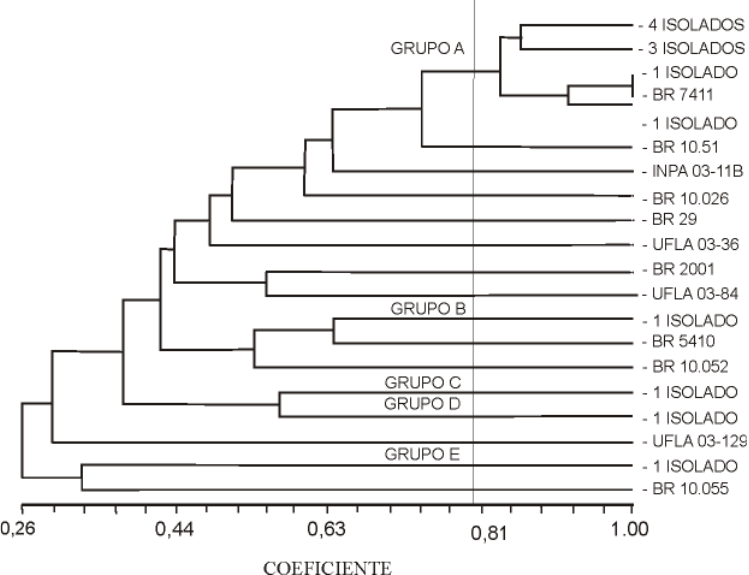
LMWM.Figura 1. Dendrograma de similaridade construído com base no perfil protéico total dos isolados nativos de caupi, das estirpes inoculantes (INPA 03-11b, UFLA 03-36, UFLA 03-84, UFLA 03-129 e BR 2001) e das estirpes tipo ER 316ci0a T (BR 10.051- Rhizobium leguminosarum bv phaseloi); CNF 42 T (BR 10.026 Rhizobium etli); HAMBI 540 T (BR 10.055- Rhizobium galegae bv orientalis); NZP 4027 T (BR 7411- Sinorhizobium melioti); ORS 571 T (BR 5410- Azorhizobium caulinodans) e de referência BR 29- Bradyrhizobium elkanii , obtidos por eletroforese em gel de poliacrilamida